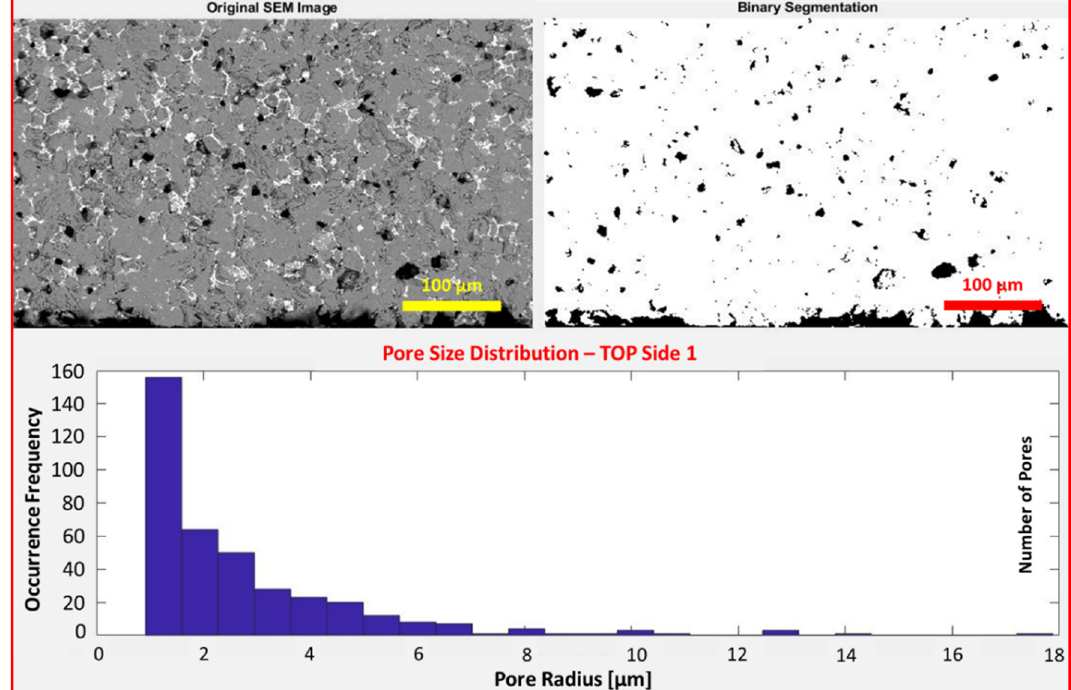
Figure 12. Quantitative porosity analysis on the top, side 1, of the cross-section after AWJ cutting.